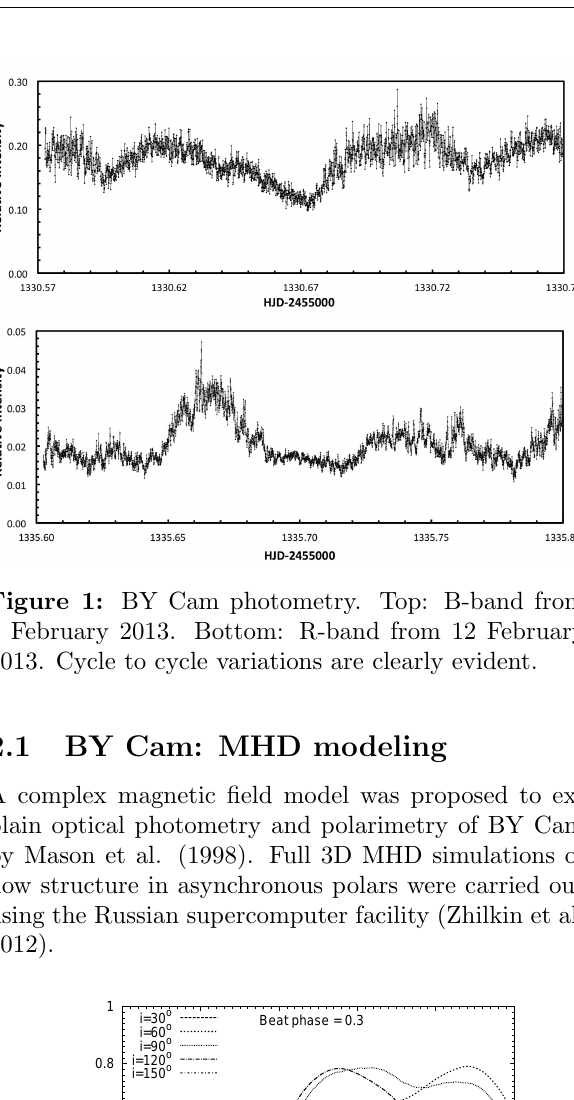
Figure 4: The magnetic induction over the surface of the model white dwarf in BY Cam. Dark areas repre- sent locations of potential accretion. There are three regions, two near the magnetic equator and one at the north magnetic pole. This is a non-aligned dipole plus quadrupole field model.